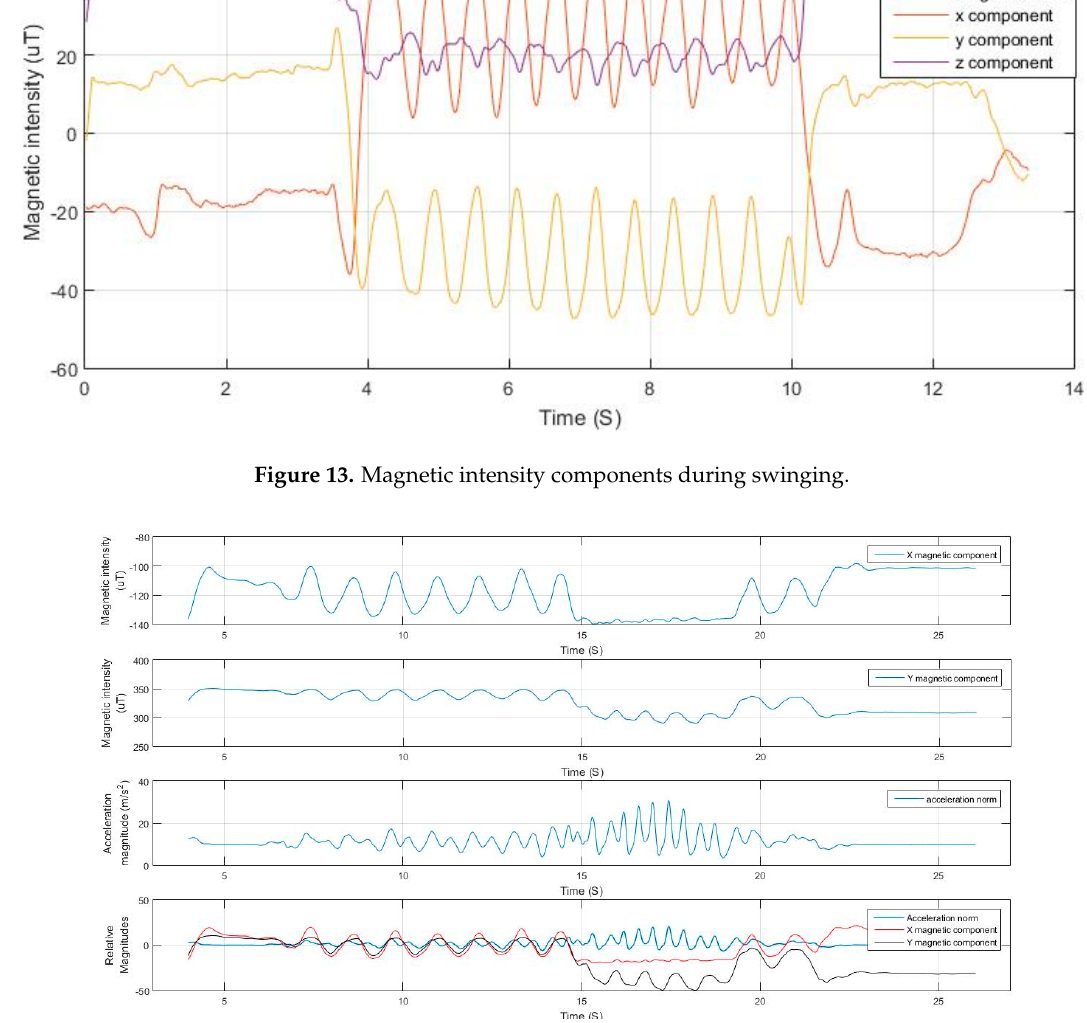
Figure 14. Acceleration norm and corresponding magnetic intensities for phone swinging case.